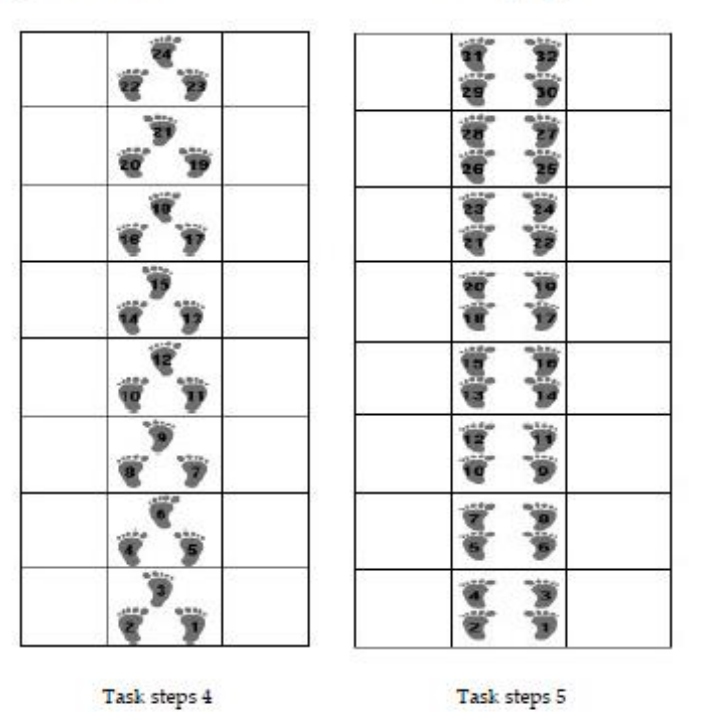
Figure 2. The basic and task steps of humanet exercise.